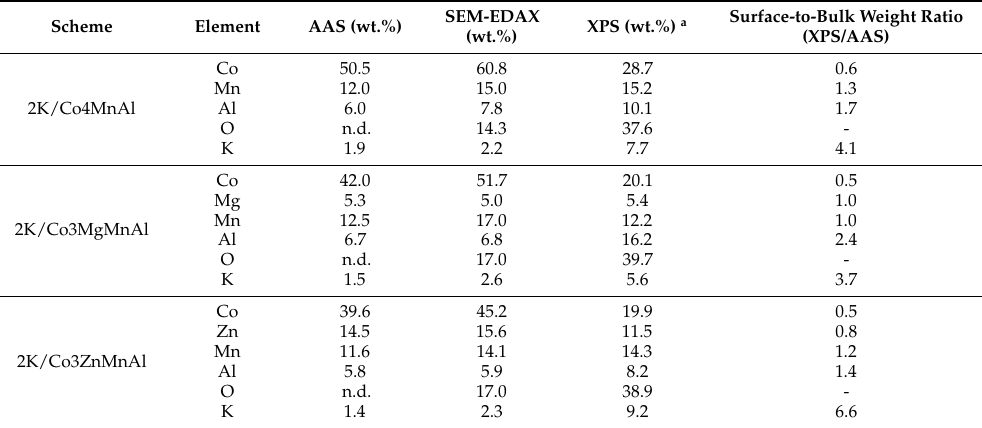
Table 4. Representation of individual elements of mixed oxide catalysts obtained by different characterisation